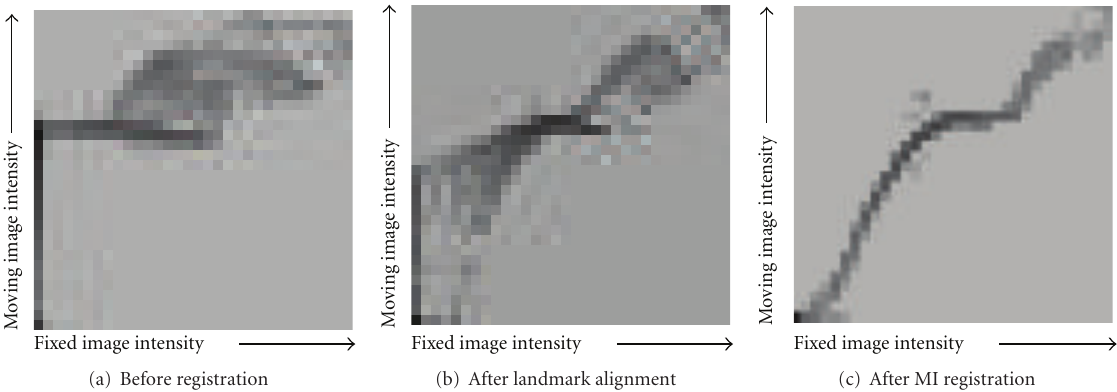
Figure 8: Joint entropy plots of simulated images showing increasing coherence with each registration stage.